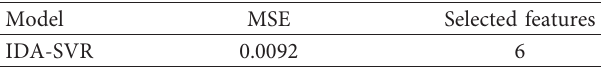
Figure 6: Boxplot representing the difference between the actual value and the predicted